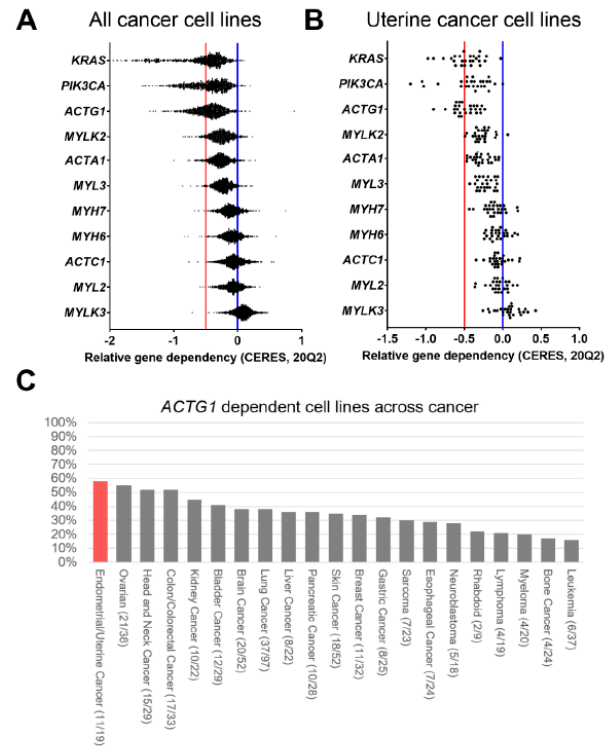
Figure 6. ACTG1 is a uterine cancer dependency based on CRISPR-Cas9 depletion screens. ( A ) The relative dependency of actomyosin genes, including ACTG1 , is shown (20Q2 release) along with the scores of the known oncogenes, KRAS and PIK3CA for all cell lines (n = 769). ( B ) The relative dependency in 19 uterine cancer cell lines is shown for actomyosin and control genes. ( C ) Cancer cell line lineages are ranked based on the percentage of cell lines that exhibited ACTG1